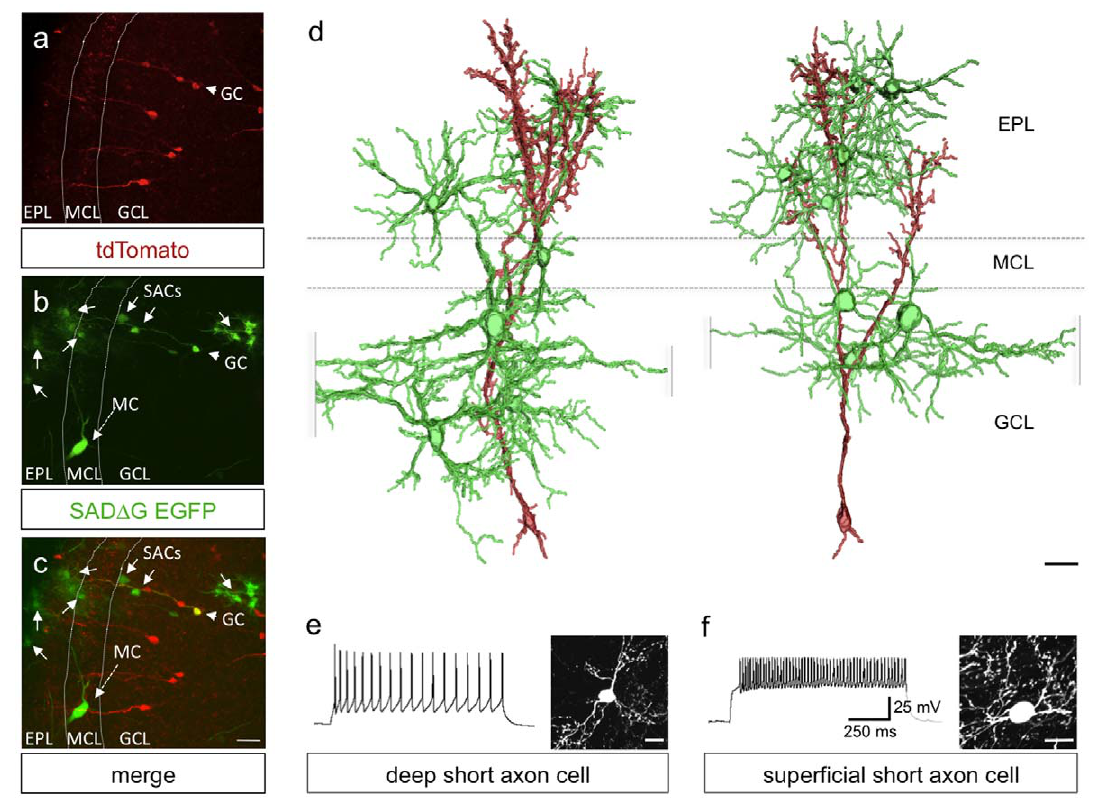
Figure 3. Newborn Granule Cells Receive Extensive Input from Short Axon Cells. (a)–(c) An SAD D G-EGFP labeled olfactory bulb microcircuit in which pre- and postsynaptic cell types can be identified by differential reporter expression. Electroporated cells appear red due to Cre activation of tdTomato expression. SAD D G-EGFP infected source cells appear yellow due to co-expression of tdTomato and EGFP. Presynaptic partners become trans-synaptically infected with SAD D G-EGFP but lack Cre and thus appear green. The dashed arrow points to a mitral cell, MC. Arrows point to short axon cells, SACs. Arrowheads indicate a source granule cell, GC. For (a)–(d): EPL, external plexiform layer; ML, mitral cell layer; GCL, granule cell layer. (a) tdTomato expression (red) in recombined Cre-expressing granule cells. (b) SAD D G-EGFP expression in a granule source cell (arrowhead) and its presynaptic targets (arrows). (c) Merge of (a) and (b). Scale bar, 20 m m. (d) Examples of volume-rendered reconstructions showing local short axon cell microcircuits with synaptic contacts onto newborn granule cells. The postsynaptic granule cells are shown in red, and the presynaptic short axon cells are shown in green. Scale bar, 15 m m. (e)–(f) Examples of action potential responses to depolarizing current injection and images of the short axon cell types observed to make synaptic contacts onto newborn granule cells. Shown are firing responses (left) and cellular morphologies (right) of a representative deep short axon cell (e) and superficial short axon cell (f) with contacts onto a newborn granule cell. Scale bars, 15 and 10 m m,